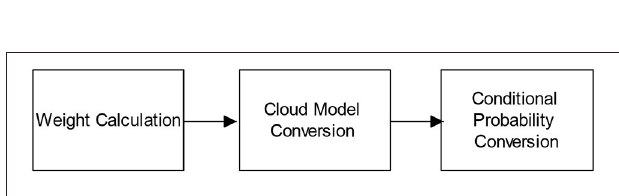
FIGURE 2 | The CPT generation